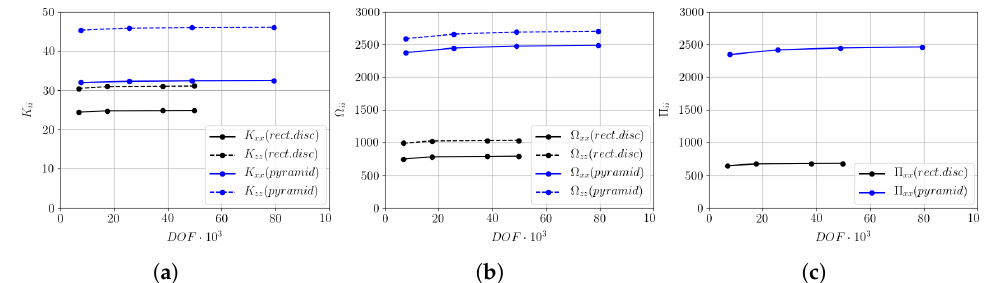
Figure 5. Demonstration of mesh convergence, by comparing the components of: ( a ) translation, ( b ) rotation and ( c ) deformation resistance tensors, for two superellipsoids: the rectangular disc ( λ 1 = 5, λ 2 = 5, e 1 = 0.2, e 2 = 0.2) and pyramid-like particle ( λ 1 = 10, λ 2 = 10, e 1 = 1.5, e 2 =